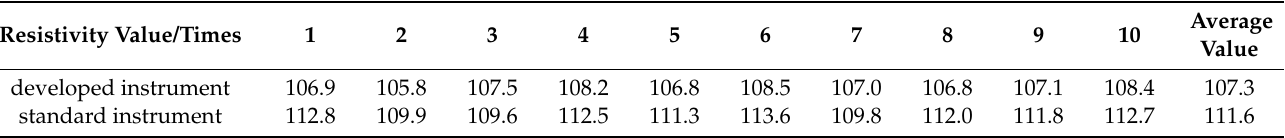
Figure 19. Site 1 of Qizhen Lake developed instrument ( a ) standard instrument; ( b ) field test diagram (unit: Ω · m). The resistivity and average values measured by developed and standard measuring instruments at Site 1 of Qizhen Lake are shown in Table 4. Table 4. The resistivity and average values measured by developed and standard measuring instruments at Site 1 of Qizhen Lake.